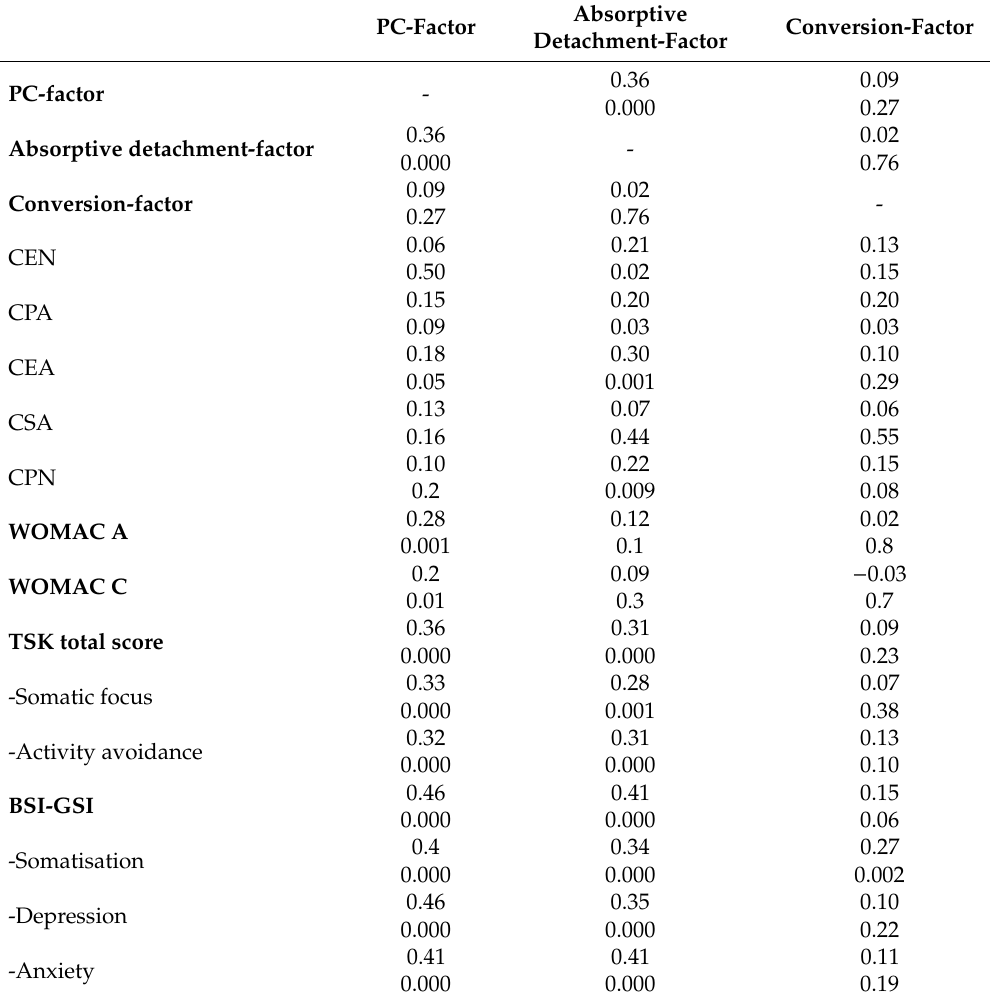
Table 4. Correlations (Kendall’s Tau, first rows and p values, second rows) of the factors 1 to 3 with WOMAC and psychometric scores and interfactor-correlations. WOMAC A: knee-pain; WOMAC C: knee-function; TSK: Tampa scale of kinesiophobia; CEA: childhood emotional abuse; CPA: